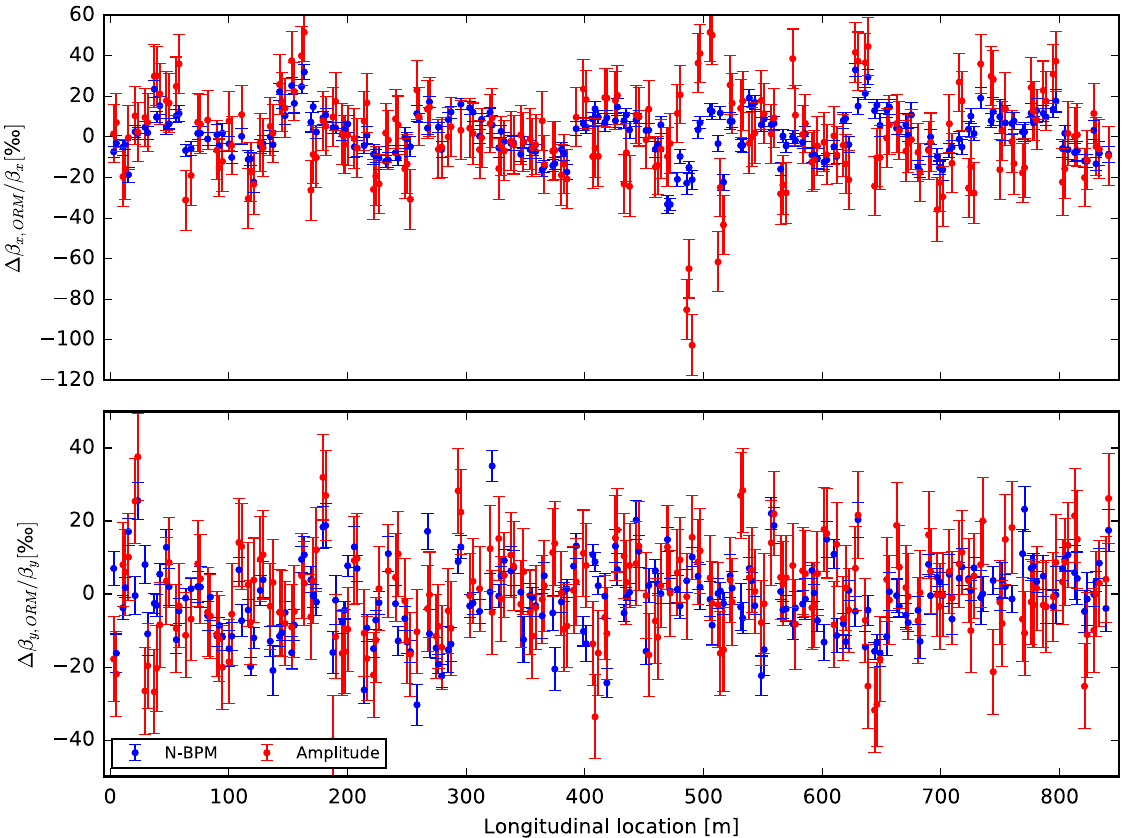
FIG. 9. Measured β -beating with respect to the ORM